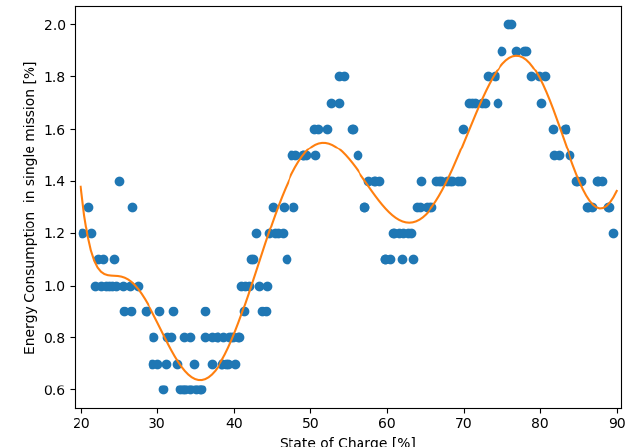
Figure 6. Curve fitting of the calibration dataset.